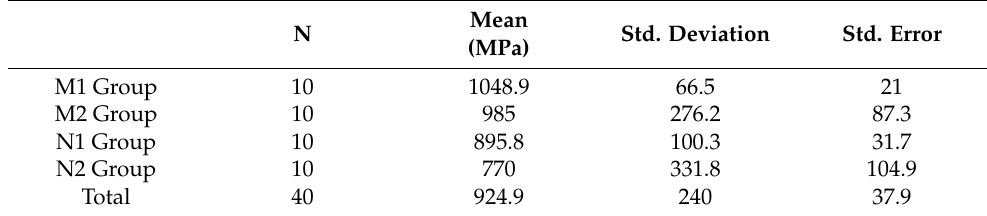
Table 2. Descriptive Statistics.